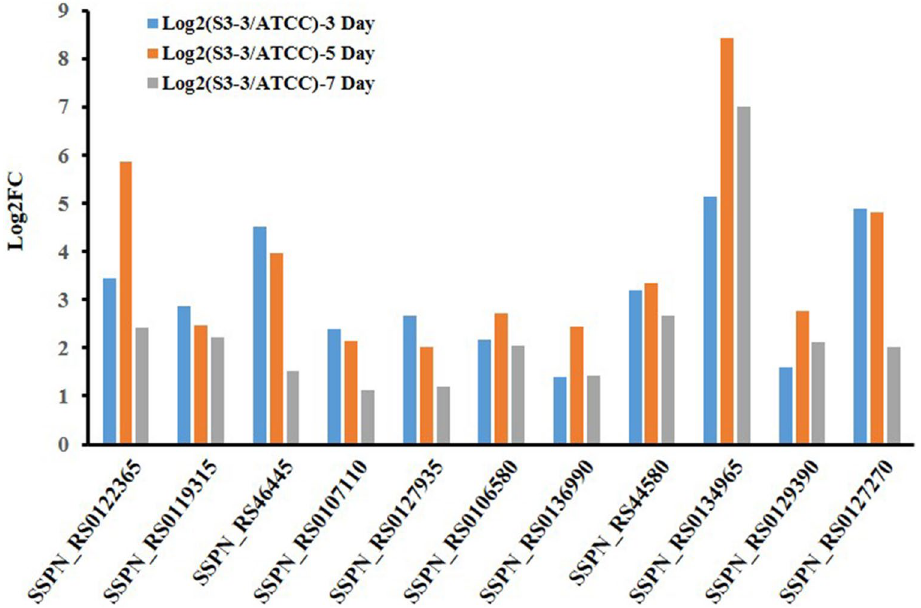
Figure 7. Transcriptional analysis of the genes related to amino acids metabolism pathway. The expression level of genes in S. spinosa ATCC_49460 was set as 1. (The chart was carried out using Microsoft Office Professional Plus